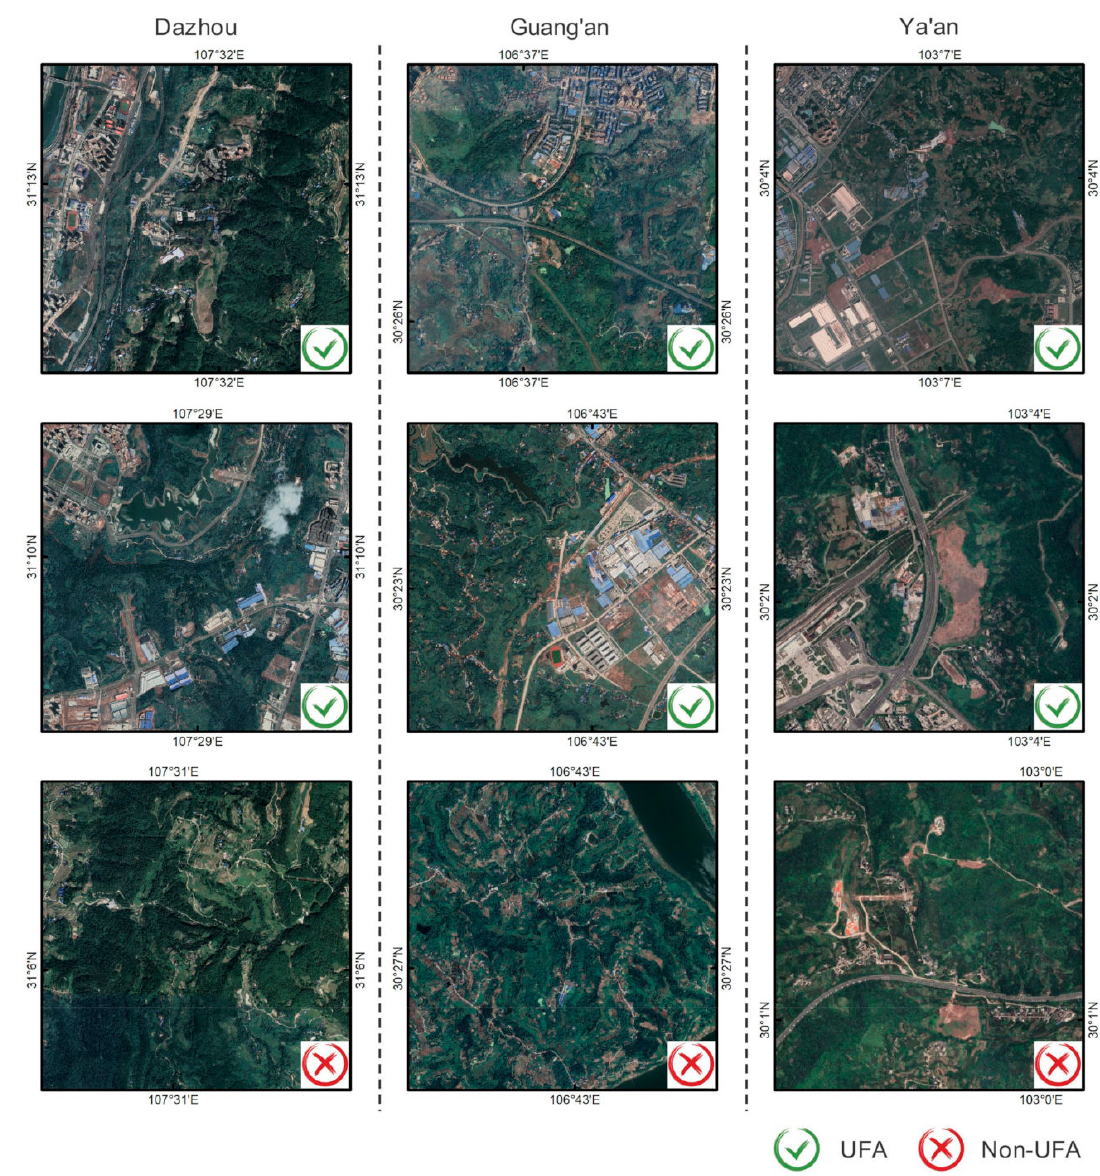
Figure A2. Remote sensing images of some sampling points in Dazhou, Guang’an, and Ya’an. The coordinate reference system is the WGS-84 coordinate